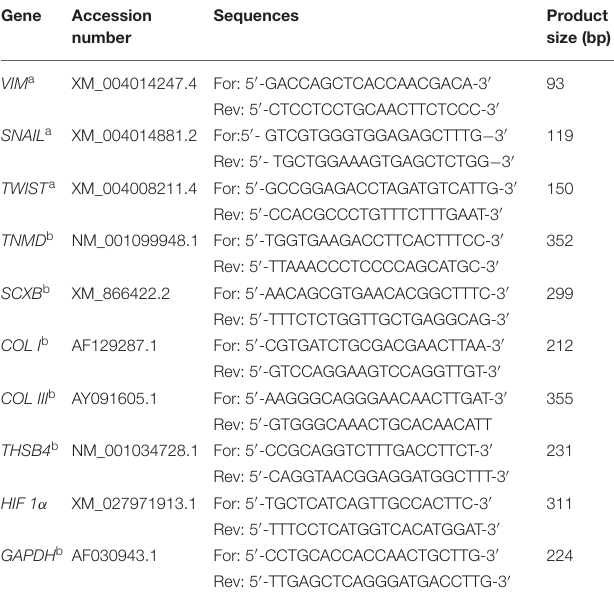
TABLE 1 | Primers details used for RT-qPCR analysis. TABLE 2 | Details of primary and secondary antibodies used for Western Blot